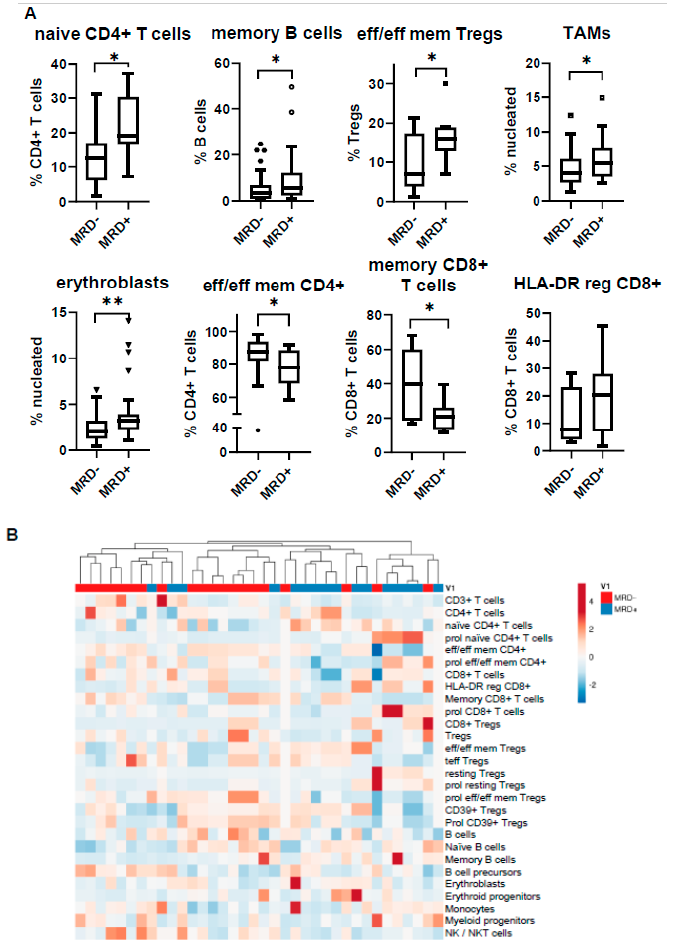
Figure 5. Bone marrow profiling of minimal residual disease (MRD)-positive (MDR+) vs . MRD-negative (MRD − ) patients. ( A ) Comparison of subset distribution according to MRD status; ( B ) heatmap displaying the unsupervised hierarchical clustering of MRD patients based on their entire immune composition. * p < 0.05, ** p <